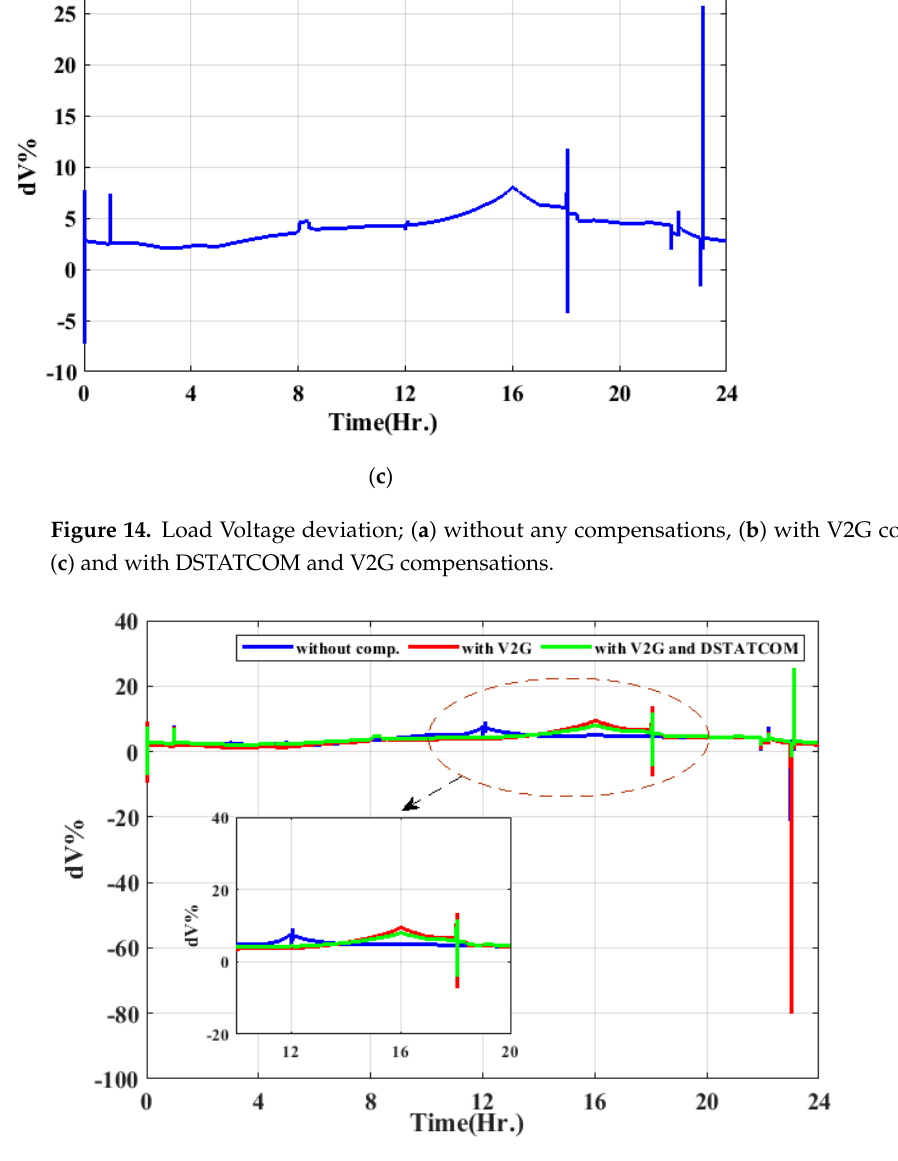
Figure 15. Load Voltage deviation for the three case studies.